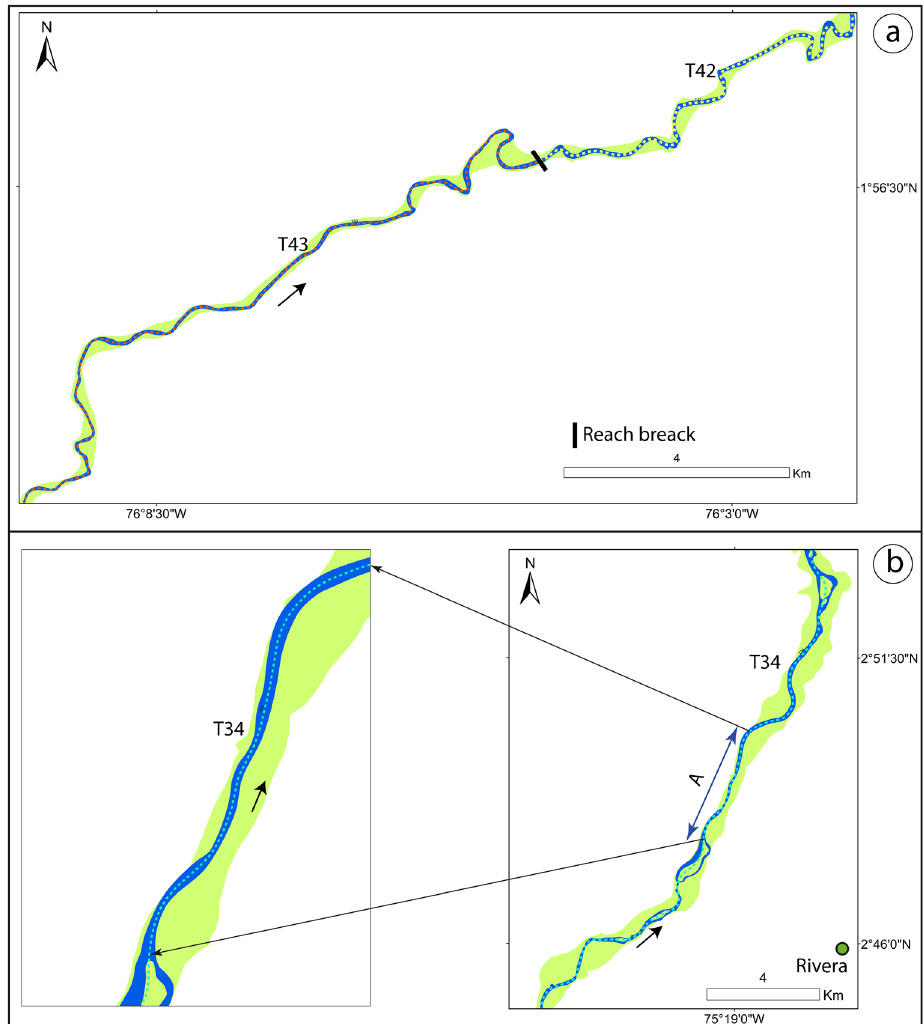
Figure 11. ( a ) Magdalena case study. Character of an emblematic partly confined reach (T42–T43): Any further break would not allow significant changes to the river character (the break between reaches T43 and T42 is due to the attribute “current”); ( b ) Magdalena case study. Example of ambiguity: partly confined Reach T34 where sub-reach A appears to be confined, but it is not (North on top).